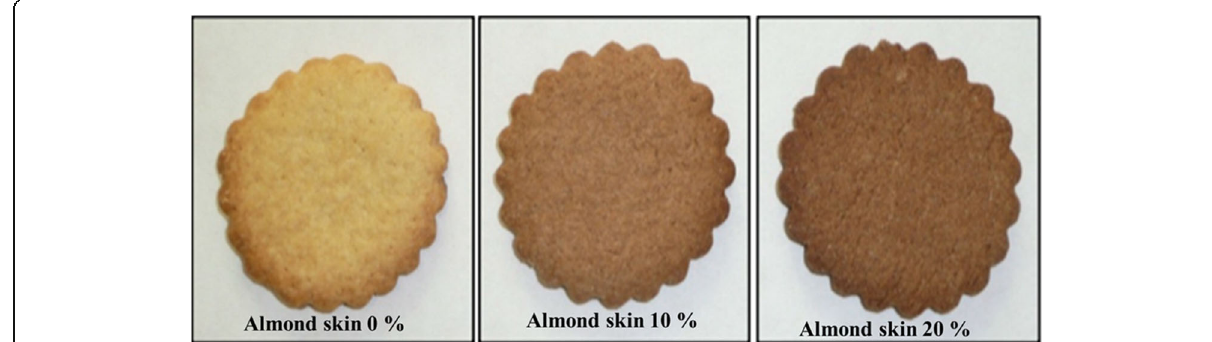
Fig. 4 Biscuits enriched with almond skins showing the change of